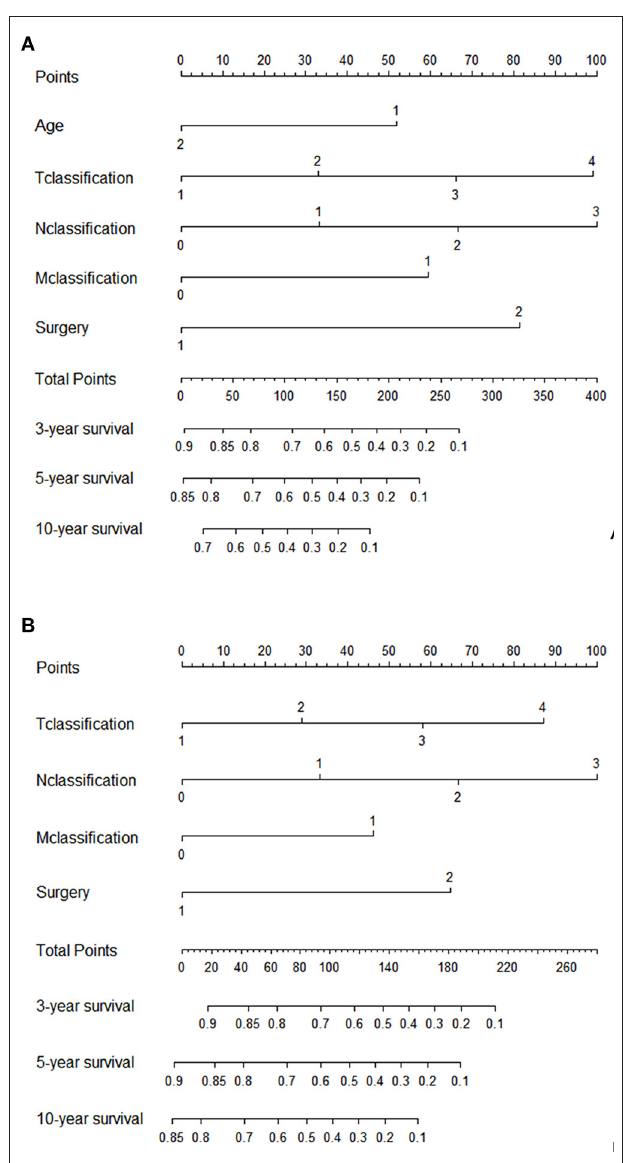
FIGURE 5 | Nomograms for prediction of 3-, 5-, and 10-year (A) OS rates; (B) CSS